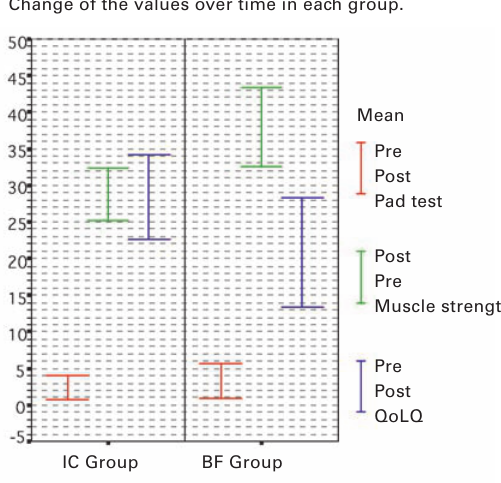
Pre and post treatment mean (95% Ci) values of the groups. Change of the values over time in each group.